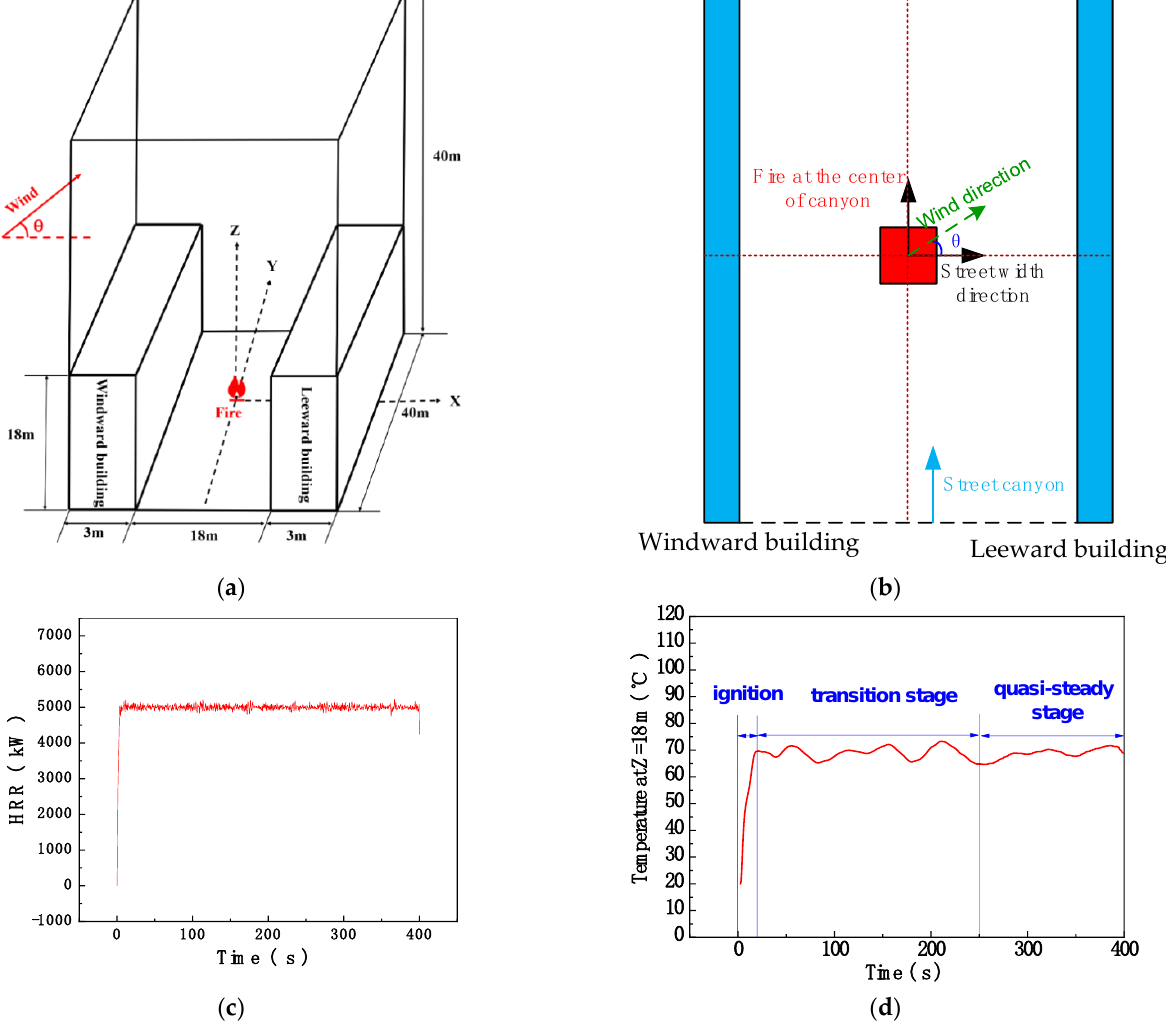
Figure 1. Model configuration of the street canyon under different wind-direction conditions: ( a ) general configuration; ( b ) top view; ( c ) time − based HRR curve; ( d ) time-based temperature curve for the no-wind case. Table 1. Summary of the simulation cases.